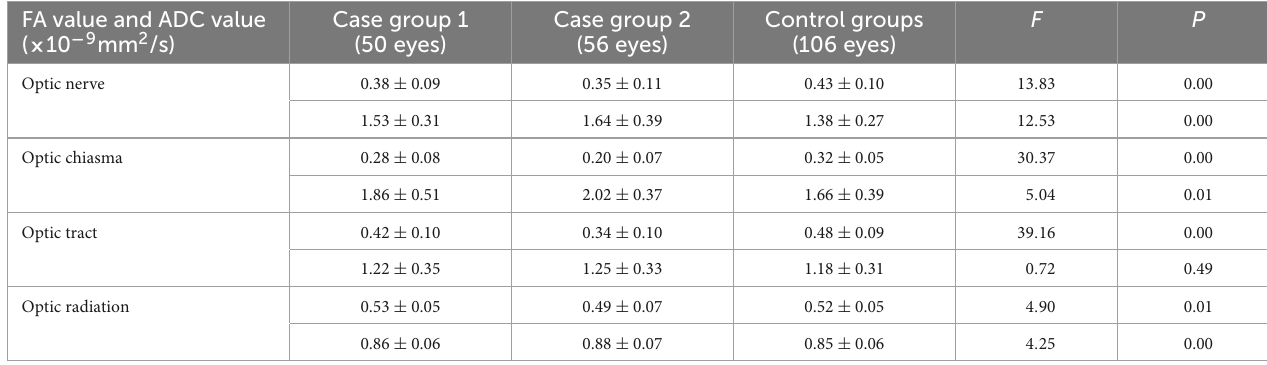
TABLE 4 Comparison of the FA value and ADC value between the two case groups and the control group. FA value and ADC value ( × 10 − 9 mm 2